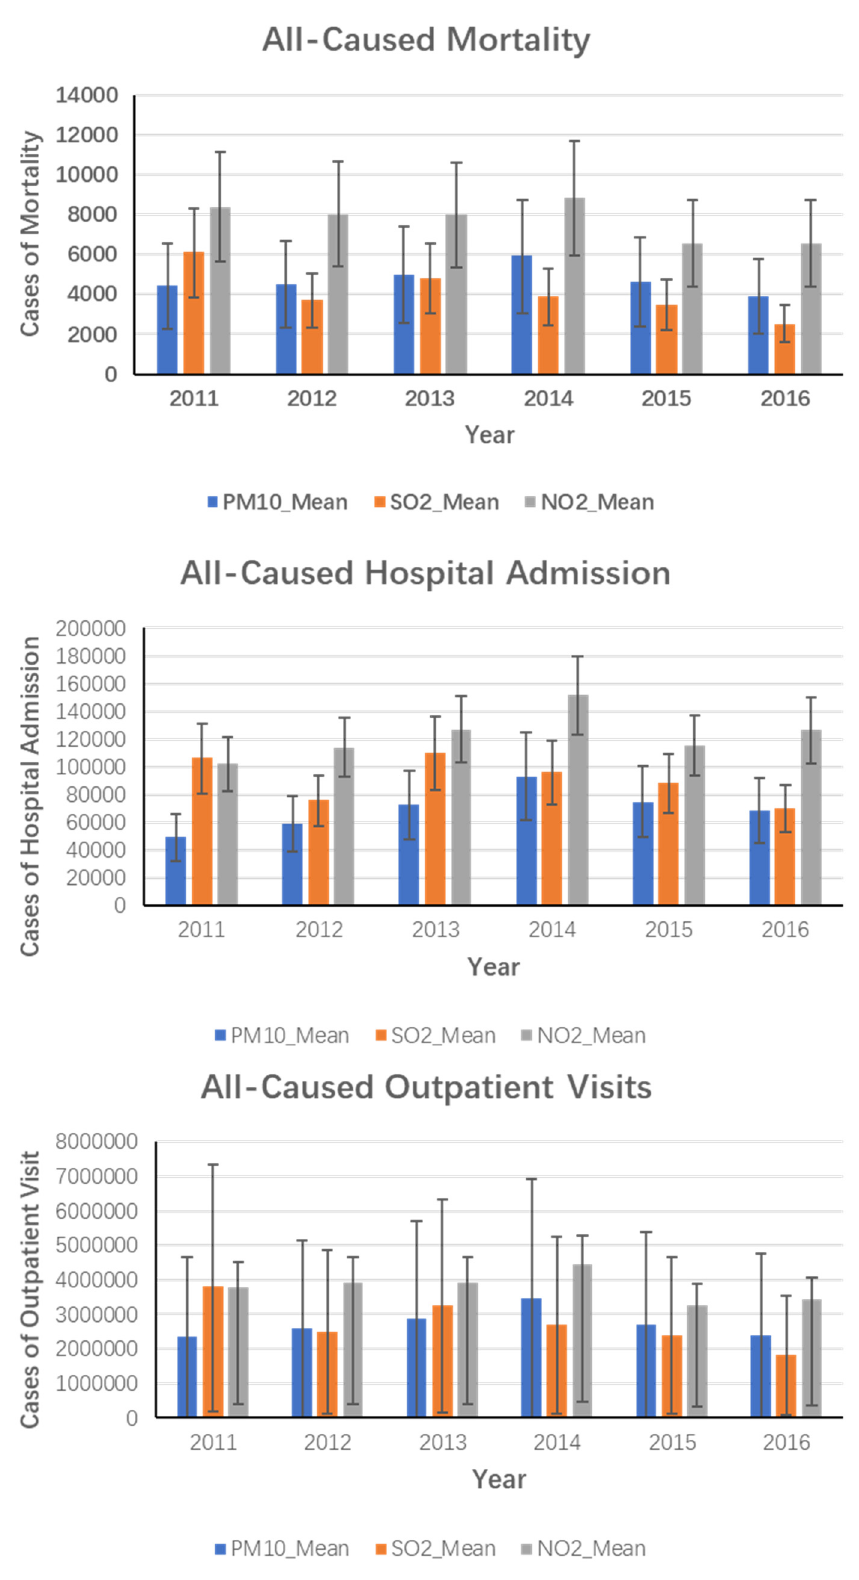
Figure 2. Health e ff ect by air pollutants in Guangxi ZAR from Figure 2. Health effect by air pollutants in Guangxi ZAR from 2011–2016.